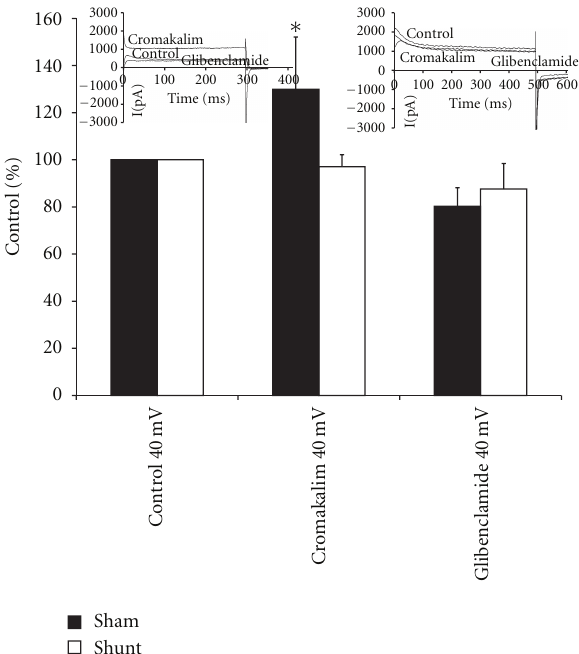
Figure 3: Comparison of E ff ects of Cromakalim and Gliben- clamide. Bars represent the sarcolemmal outward potassium cur- rent density amplitude, expressed as percentages of the control val- ues of ventricular myocytes from control, sham-operated and shunted, volume-overloaded rats, measured at the clamp voltage of +40 mV under conditions of pretreatment with cromokalim and post-treatment with glibenclamide. Asterisk ( ∗ ) indicates statisti- cally significant di ff erence from control and shunt at P < 0 . 05. Inserts are raw data recordings showing the amplitudes of outward potassium currents (I), expressed in pA, acquired at a membrane clamp voltage of +40 mV during the control condition, pretreat- ment with cromokalim and post-treatment with glibenclamide; left insert from a sham-operated control and right insert froma shunted volume-overloaded